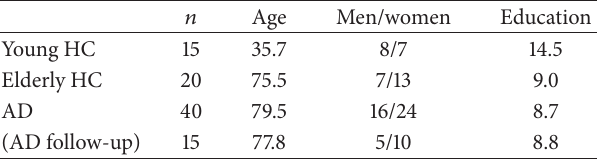
Table 1: Demographics of the study